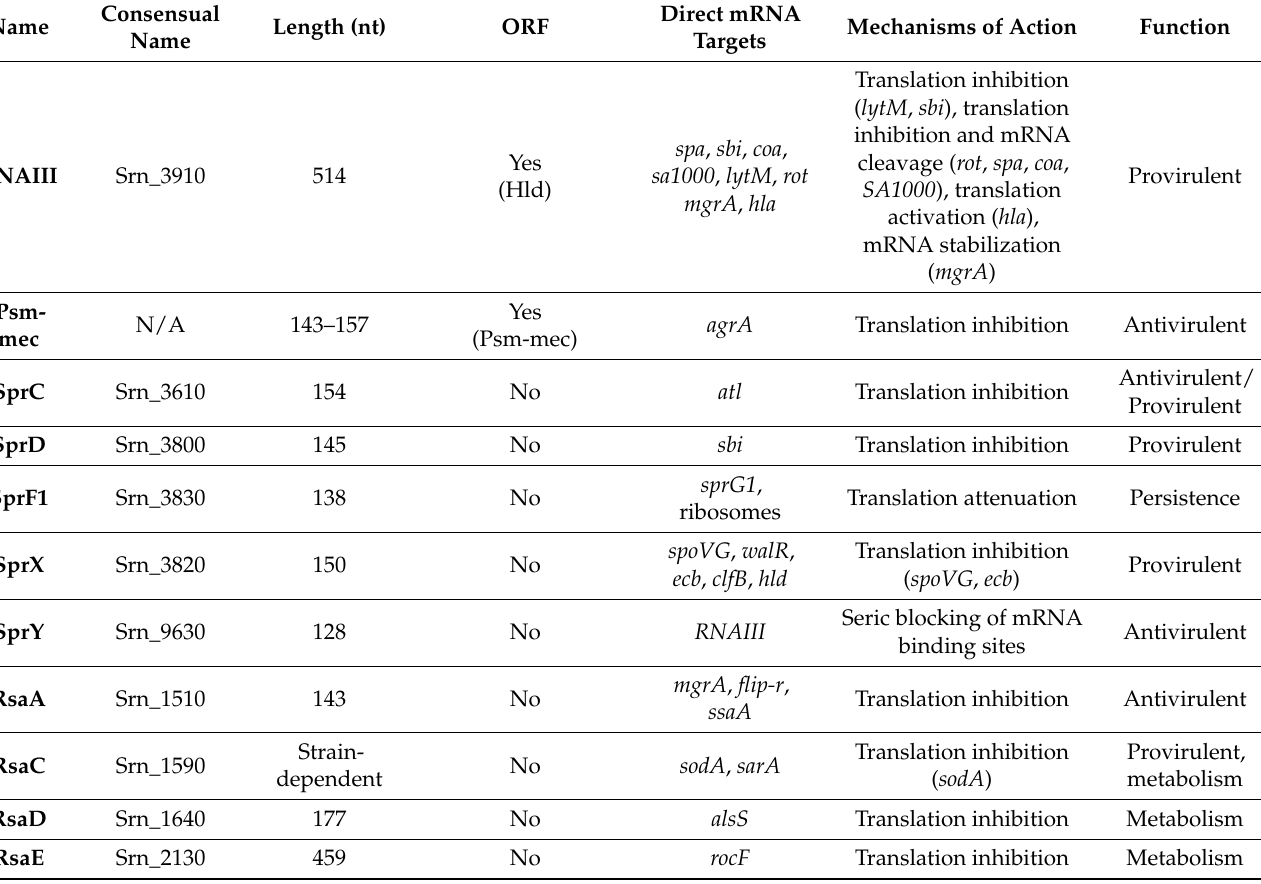
Table 2. Important features of sRNA characterized in Staphylococcus aureus . ORF: open reading frame; N/A: not